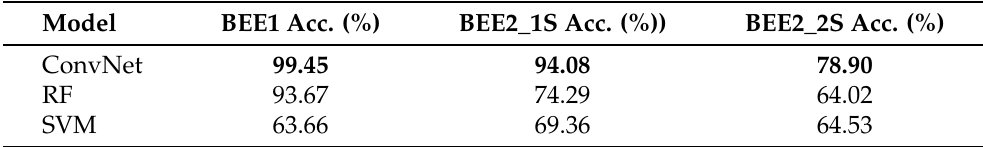
Table 9. Validation accuracies of each model type on BEE1, BEE2_1S, and BEE2_2S; best accuracies are in